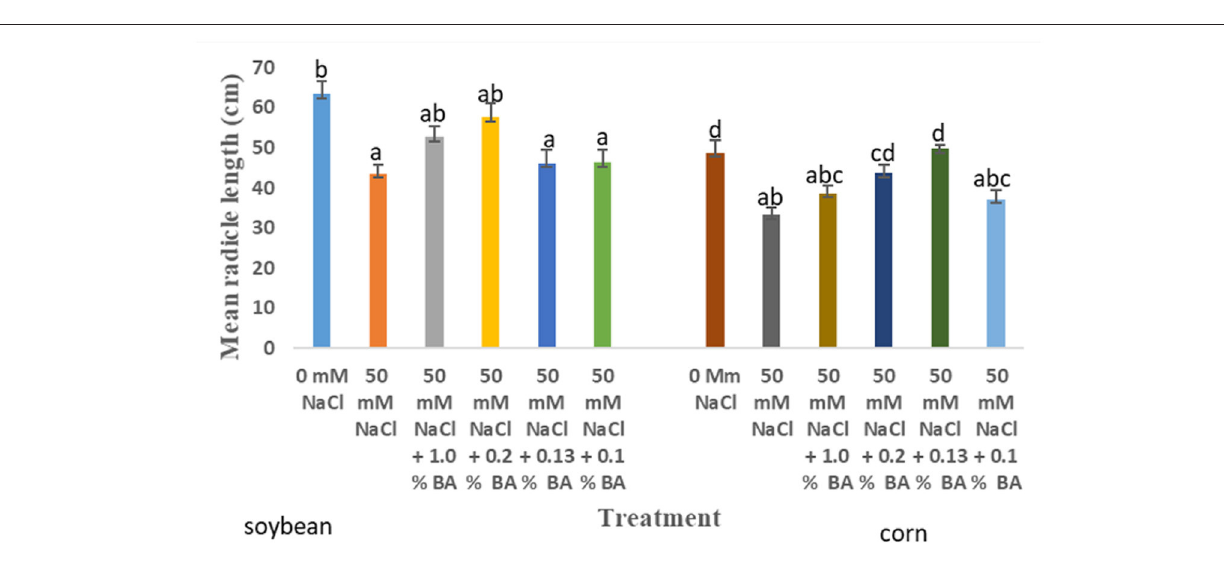
75 mM NaCl, even to corn treated with BA and M13 cell-free